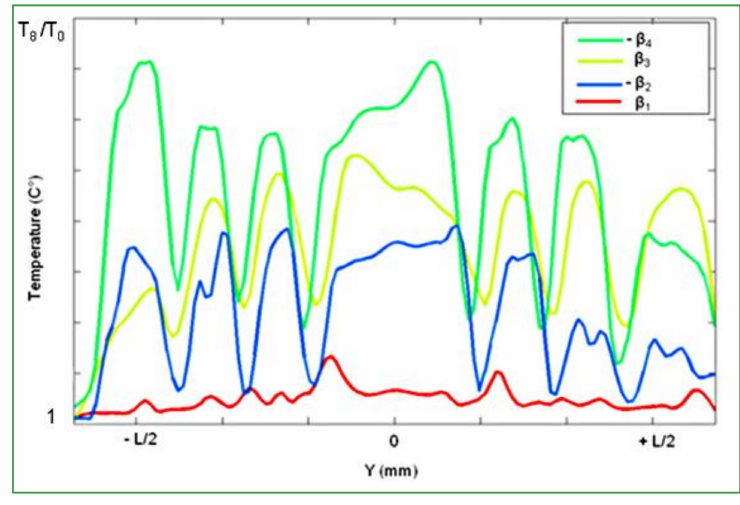
Figure 5. The variation of skidding angles for loading l 3 = 200 kN and velocity lower than 120